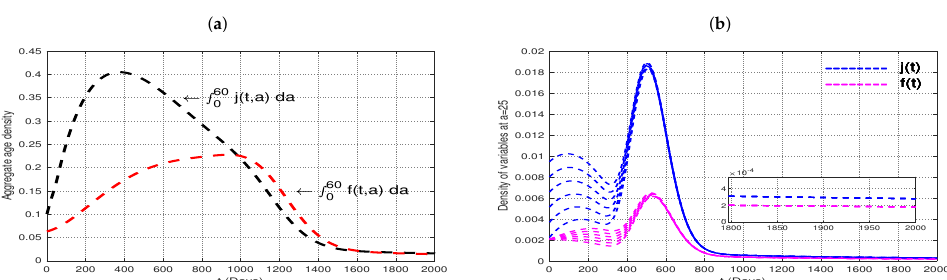
Figure 6. The stability of the endemic steady state of model (4) with the basic reproduction number R = 2.969 > 1, which implies that the disease is persistent: ( a ) the cumulative distributions of j ( t , a ) 0 (cid:82) 60 (cid:82) 60 j ( t , a ) d a and f ( t , a ) d a ; ( b ) the trajectories of i ( t ,25 ) and j ( t ,25 ) starting and f ( t , a ) , that is, 0 0 from differential initial values.